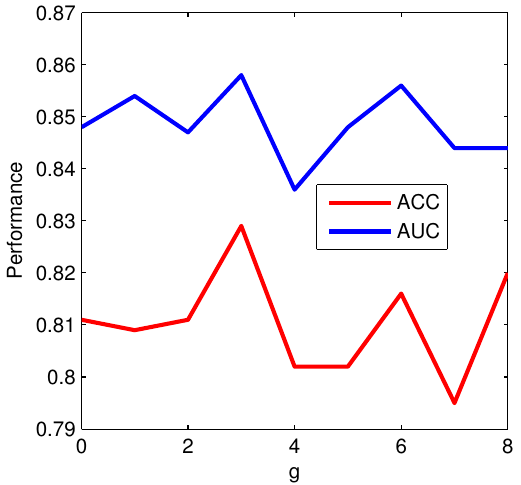
Figure 3. The performance of g -gap dipeptide composition features with various g values on the trainning dataset. Acc: Accuracy, AUC: Area Under the ROC Curve.